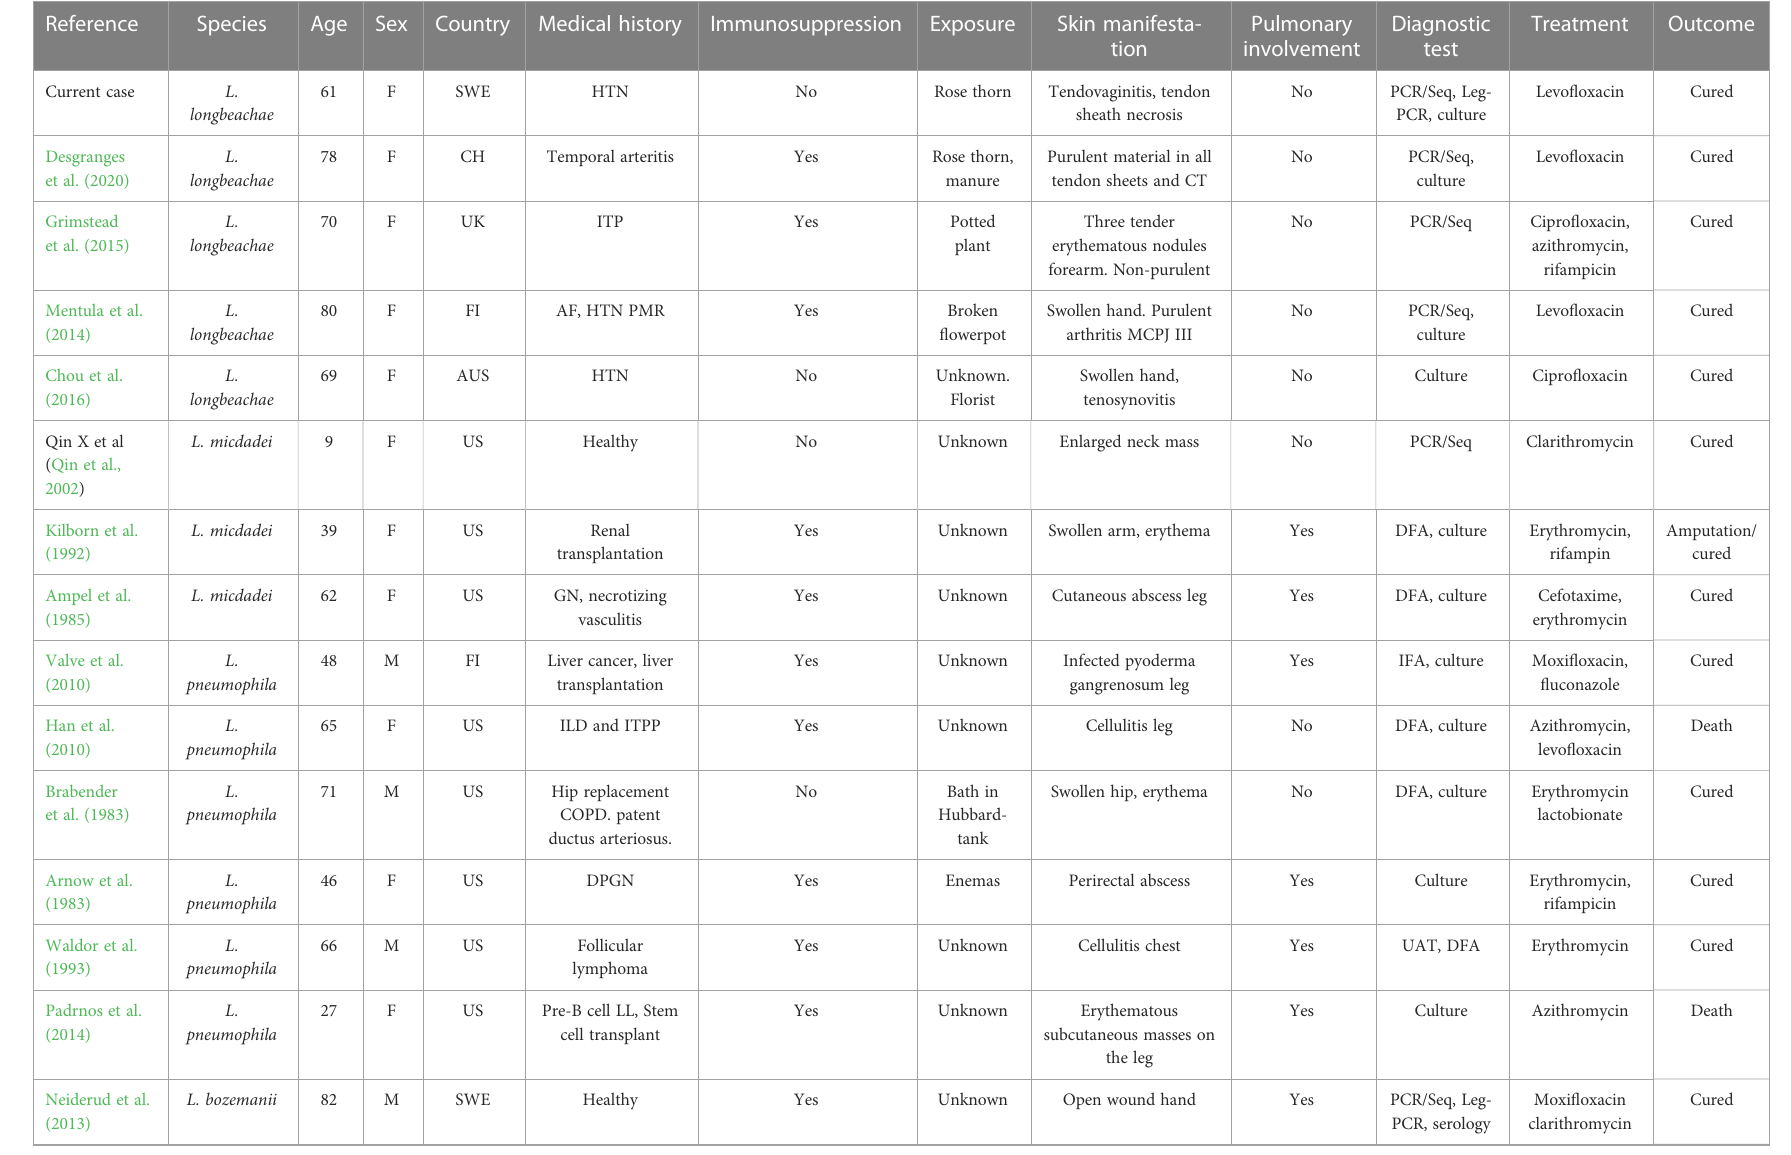
TABLE 1 Patient group